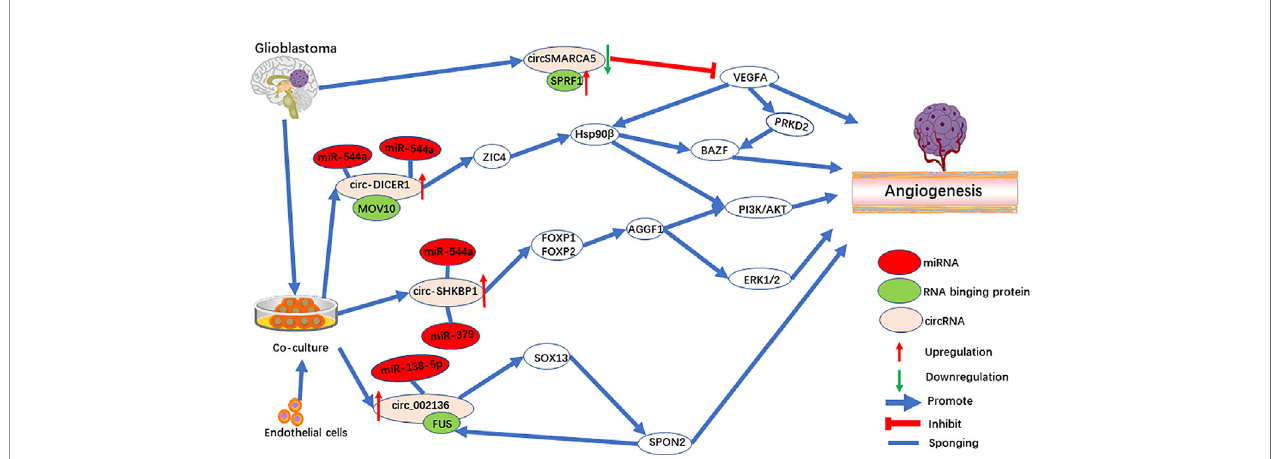
FIGURE 3 | The role of circRNAs in pro-angiogenesis and anti-angiogenesis in